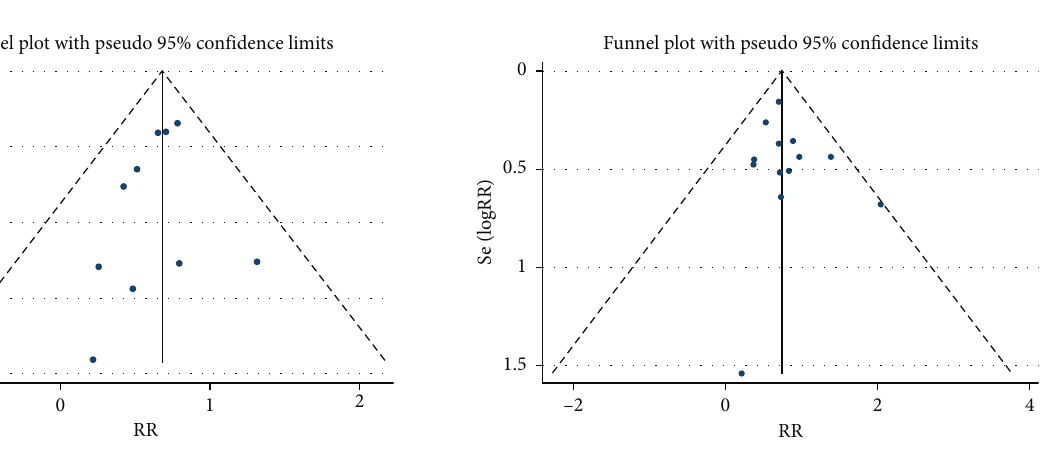
Figure 5: Comparison of MACE between the experimental group and the control group (funnel plot). RR � risk ratio; MACE � major adverse cardiovascular